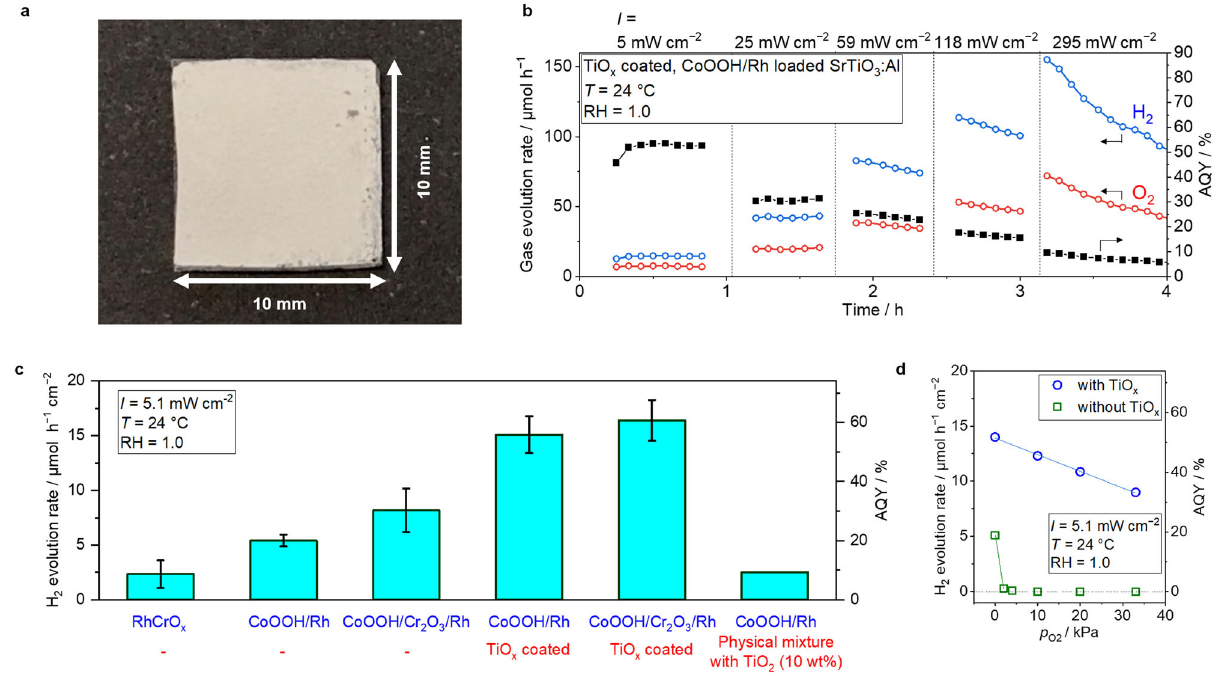
c H 2 evolution rate ofvarious cocatalysts loadedSrTiO 3 :Alirradiatedwith 370nm LED (5.1mWcm − 2 ) under saturated water vapor balanced with Ar at 24°C (10mLmin − 1 , p H2O =2.9kPa). Error bars are standard error from other samples ( n =3 – 11). d Dependence of H 2 evolution rate of CoOOH/Rh loaded SrTiO 3 :Al coated with TiO x (blue circle) and without TiO x (green square) under various O 2 partial pressure ranged from 0 to 33kPa under 370nm LED (5.1mWcm − 2